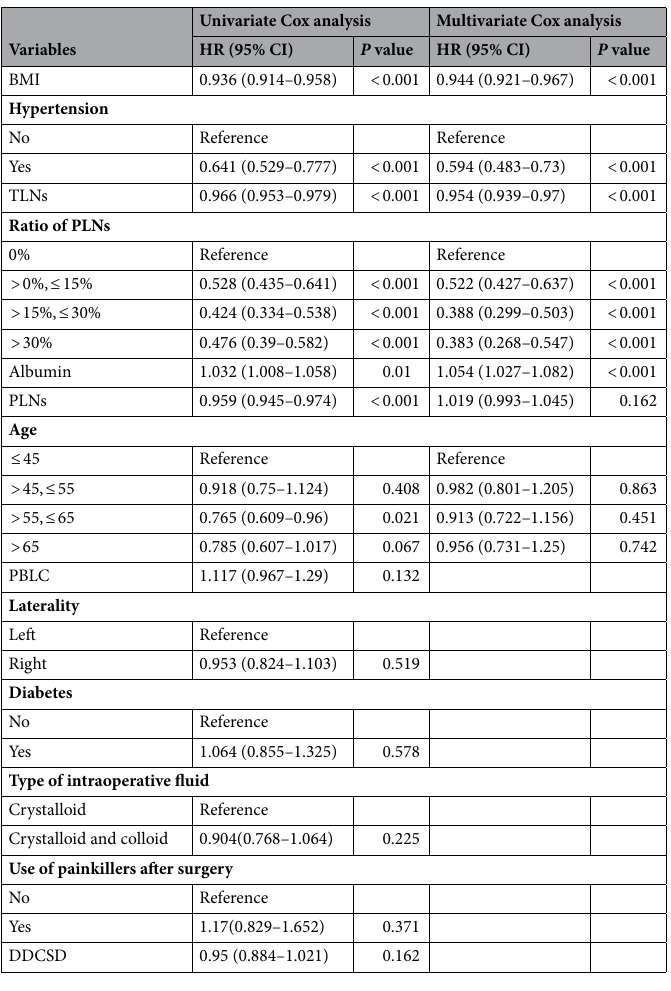
Table 2. Univariate and multivariate Cox regression analysis of factors affecting axillary drainage duration in patients with breast cancer after modified radical mastectomy. HR, hazard ratio; BMI, body mass index; DDCSD, drainage duration of chest wall suction drain; PBLC, peripheral blood lymphocyte count; PLNs, number of positive axillary lymph nodes; Ratio of PLNs, ratio of positive axillary lymph nodes; TLNs, number of total dissected axillary lymph